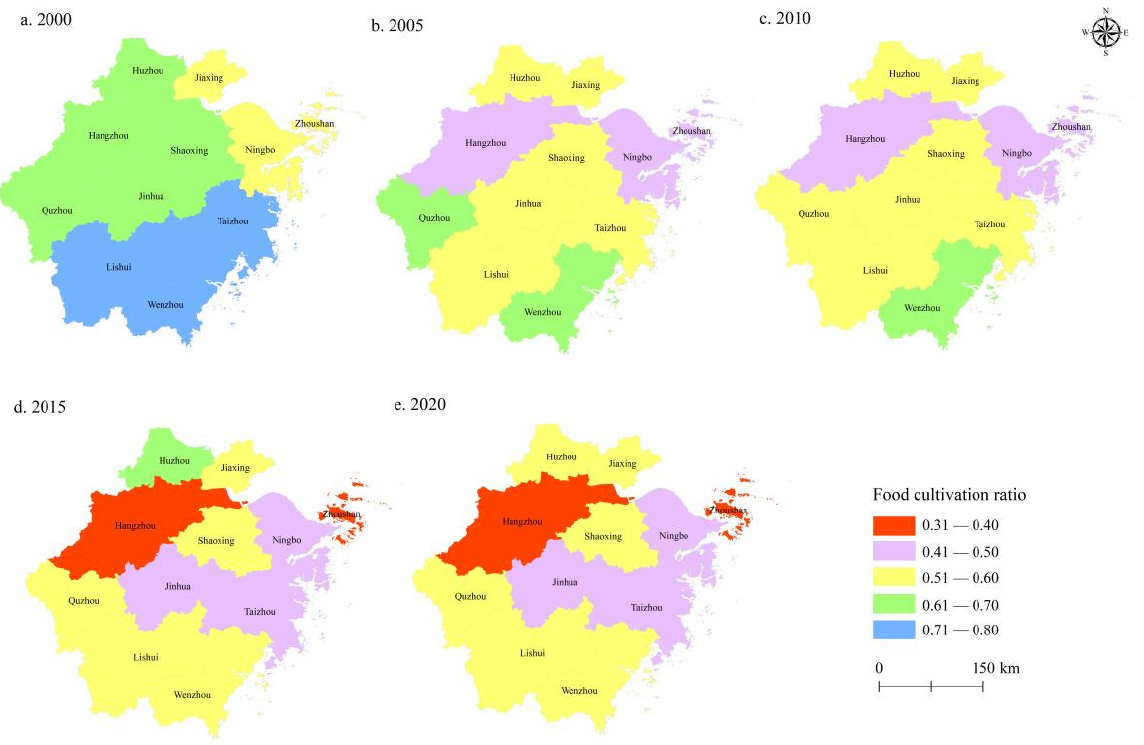
Figure 1. Trend of food planting ratio of cropland in Zhejiang province from 2000 to 2020.